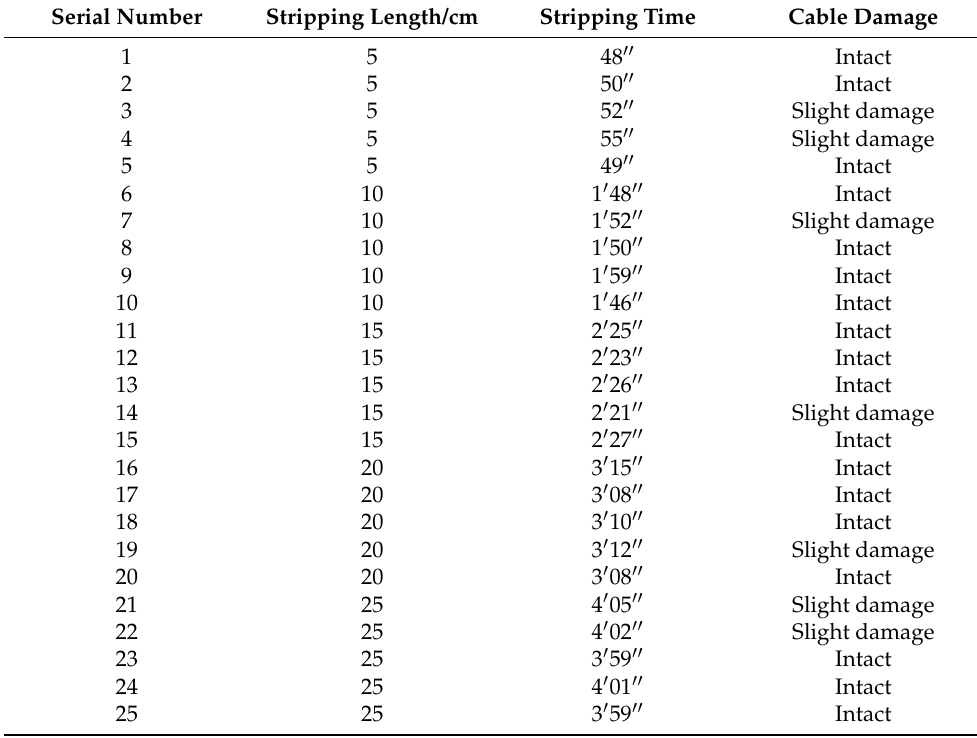
Table 2. Test data for wire-stripping experiments.